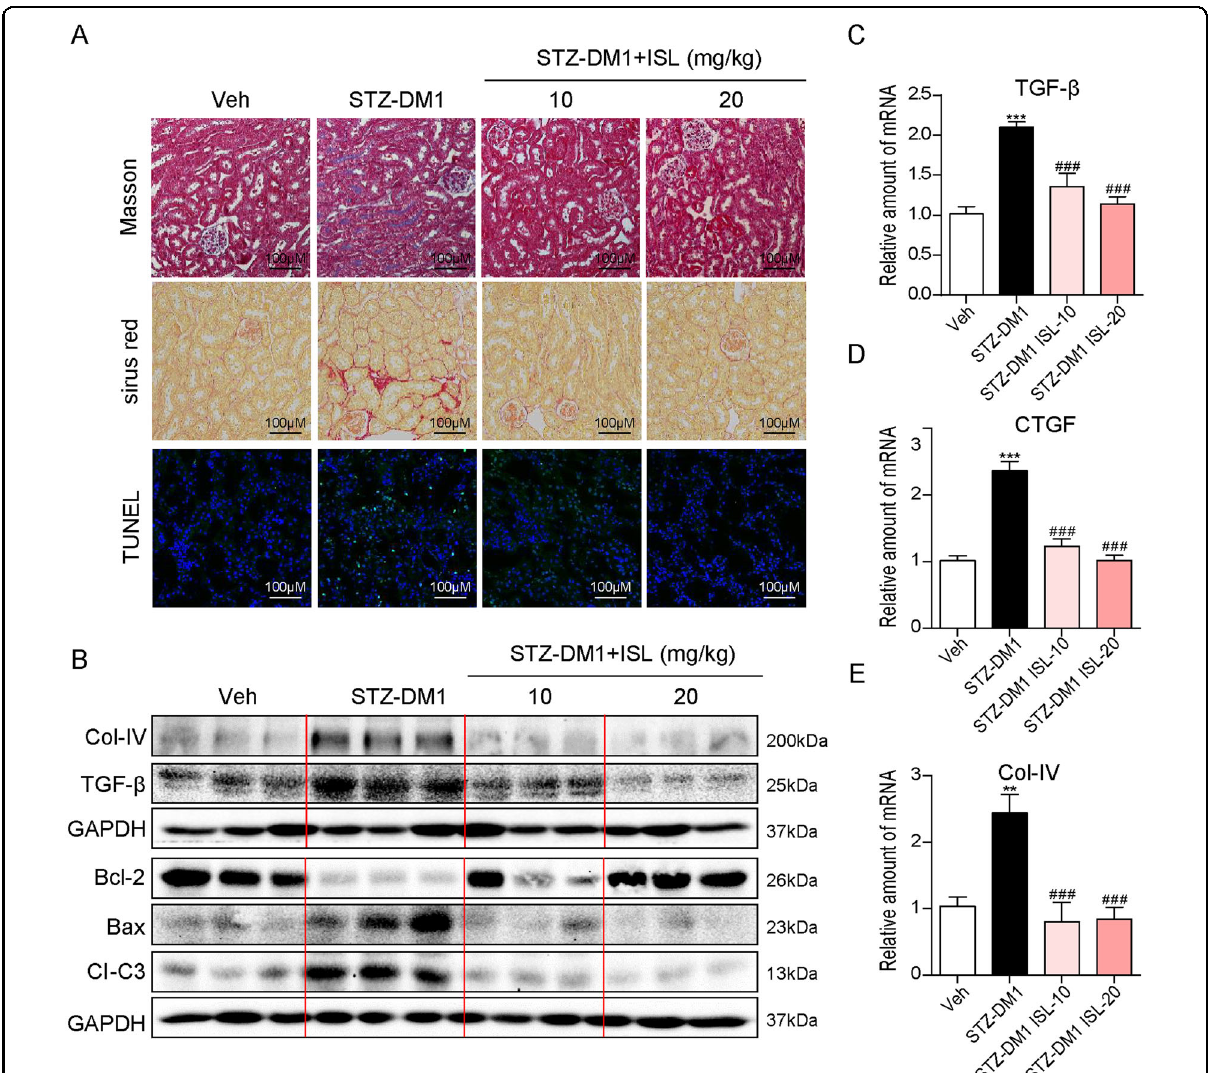
Fig. 2 ISL suppressed hyperglycemia-induced renal fi brosis and apoptosis. a Representative images for Masson staining, Sirius red staining, and TUNEL staining using the formalin- fi xed renal tissues as speci fi ed in Methods and materials (×200 magni fi cation). b Western blot analysis for the protein expression of COL-IV, TGF- β , BCL-2, BAX, and CI-C3 in three kidney tissue extracts, each from a different mouse. c – e The mRNA expression of pro- fi brotic genes TGF- β , CTGF, and COL-IV in the kidney tissues was determined by real-time qPCR (A minimum of fi ve mice per group were used for analysis. ** P < 0.01, *** P < 0.001 vs control (Veh); ### P < 0.001 vs